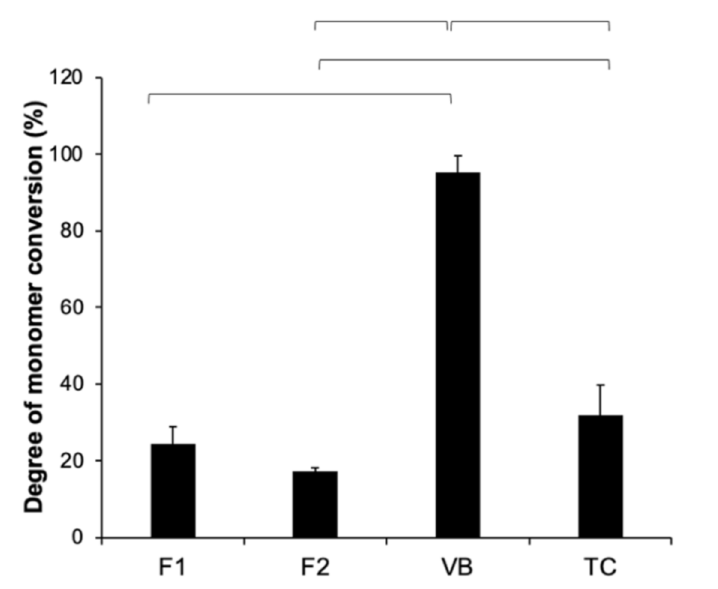
Figure 5. Degree of monomer conversion of all materials after light-curing for 40 s. Error bars are SD ( n = 3). The lines indicate p <